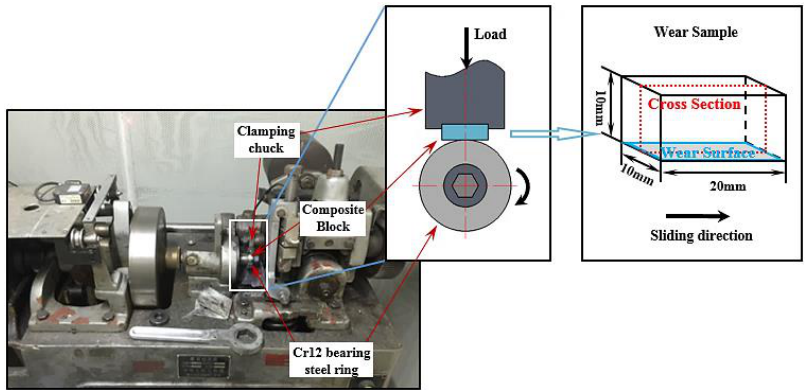
Figure 2. Schematic illustration of the block-on-ring type wear test machine.